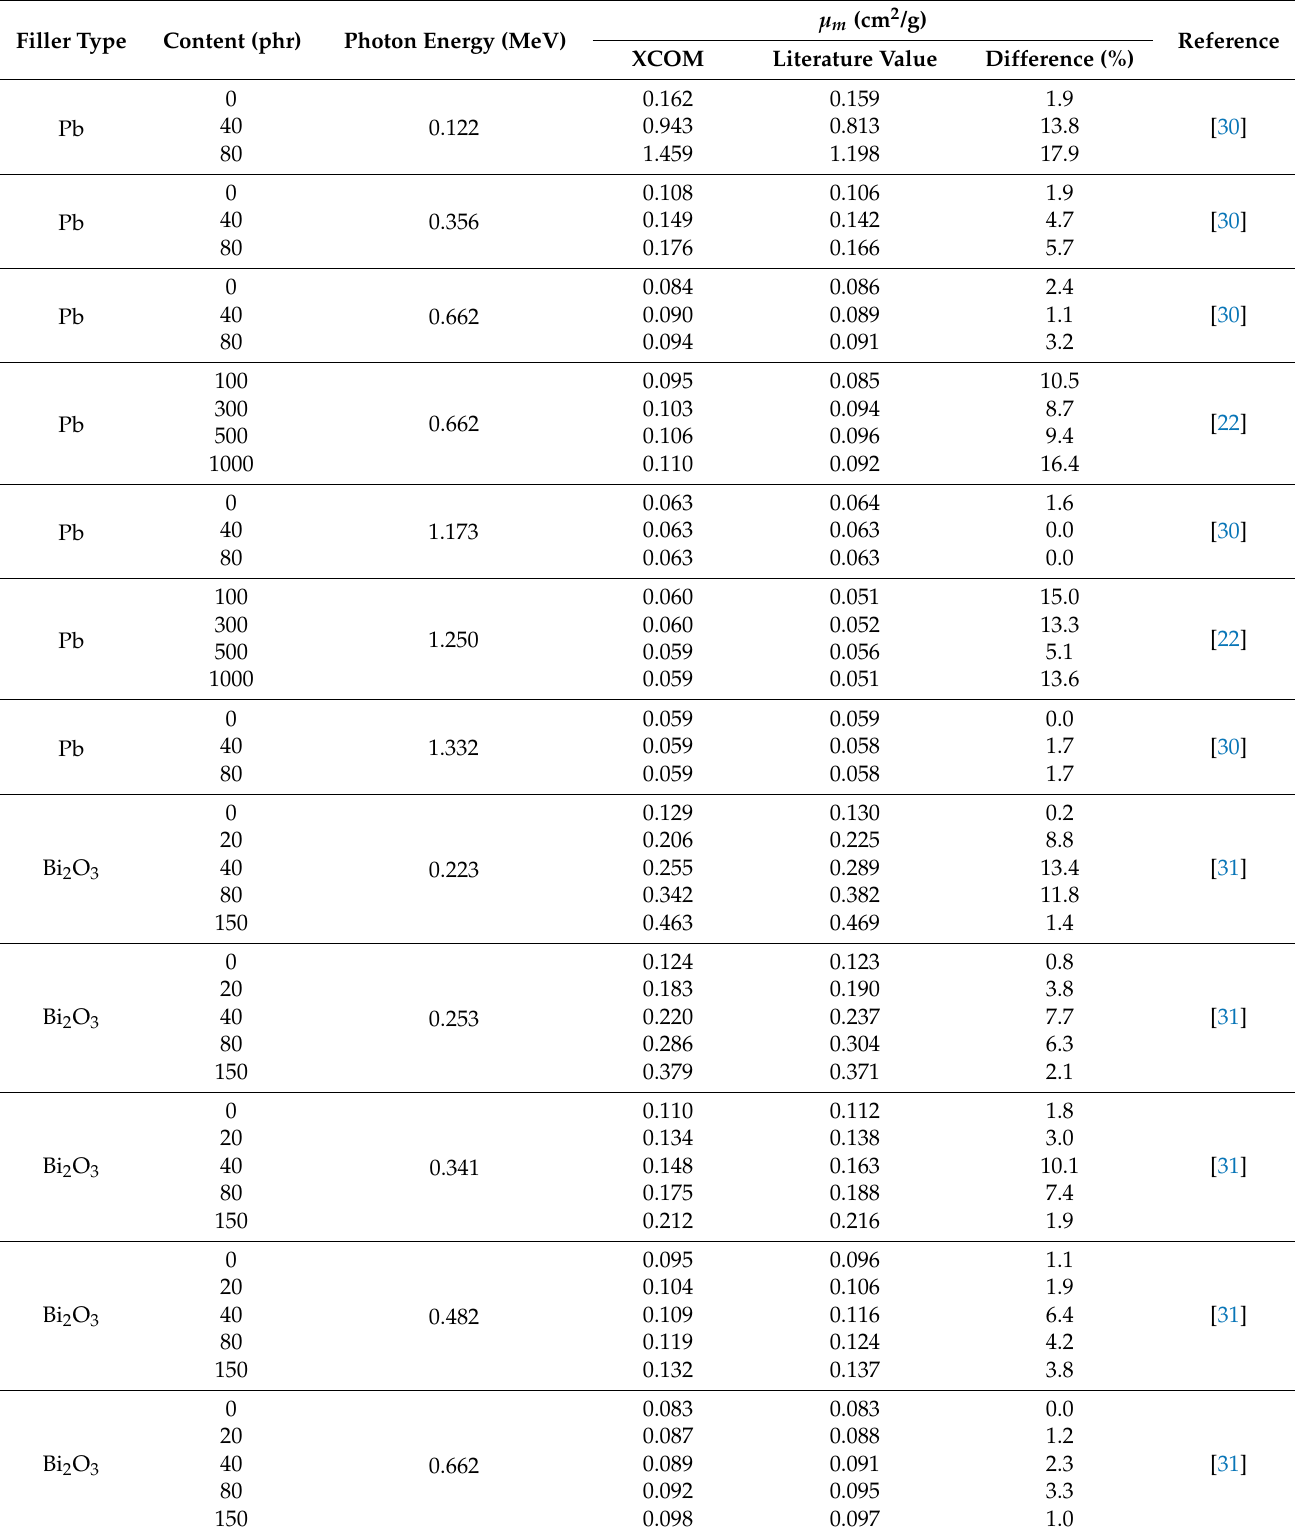
Table 2. Comparative µ m values from simulated data using XCOM and previously reported experimental results of NR composites containing different filler types/contents at various photon